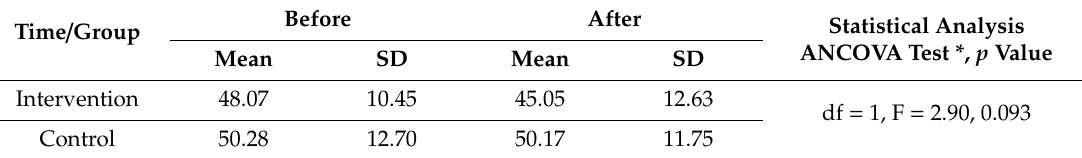
ANCOVA Test *, p ValueMean SD Mean SD df = 1, F = 2.90, 0.093